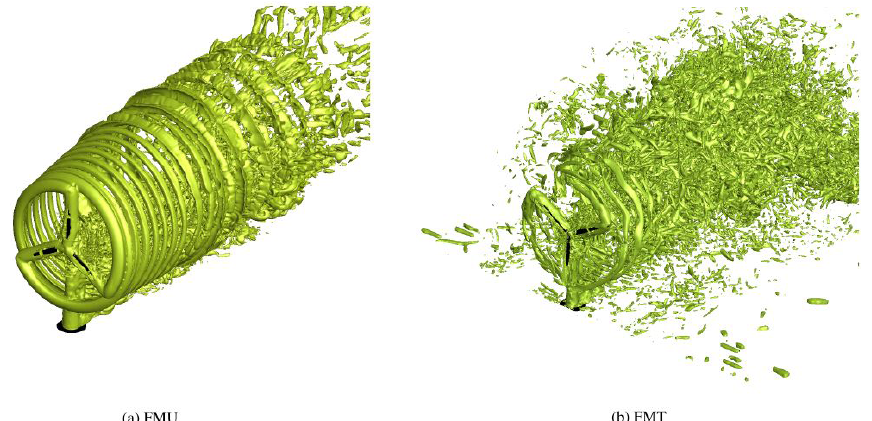
Figure 14. Visualization of the λ 2 criterion.